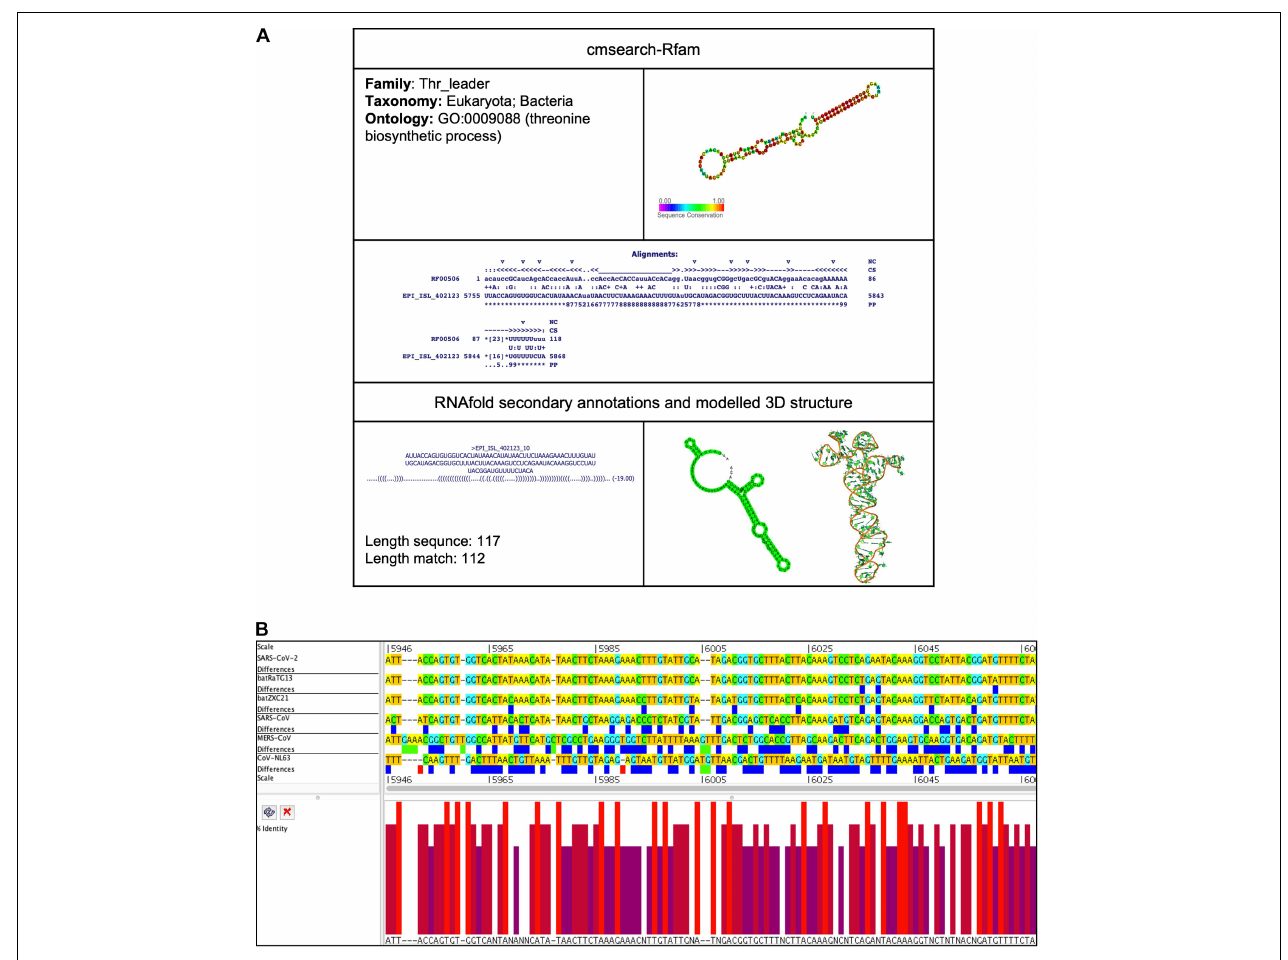
FIGURE 4 | Thr_leader cis -acting RNA element in the SARS-CoV-2 genome. (A) The sequence and RNA structure of Thr_leader is located in te position 5,755–5,868 of the SARS-CoV-2 genome. In the 3-D structure, the phosphodiester backbone is shown in orange, and the nucleotides are shown in the sticks and filled rings with elemental coloring as C green, O red, and N blue. (B) Conservation of Thr_leader RNA sequence from various CoVs. The Thr_leader is located as aligned position 5,946–6,067. The navy blue box indicates mismatched nucleotides between the two sequences, and the red box shows gaps between two sequences. Percentage identity in the histogram in which red indicates a perfect match and magenta indicates the low similarity of nucleotide.